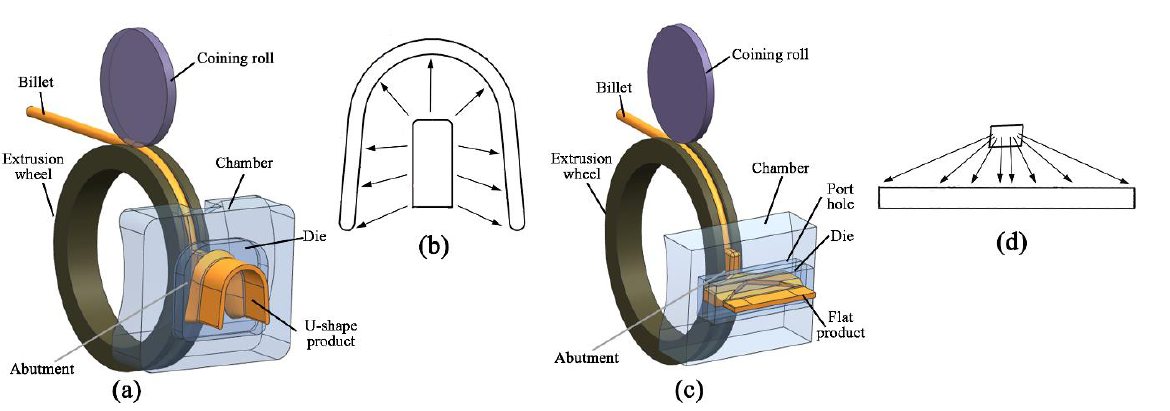
Figure 1. Schematic diagram of continuous extrusion: ( a , b ) U-Shaped strips; ( c , d ) Flat strips.